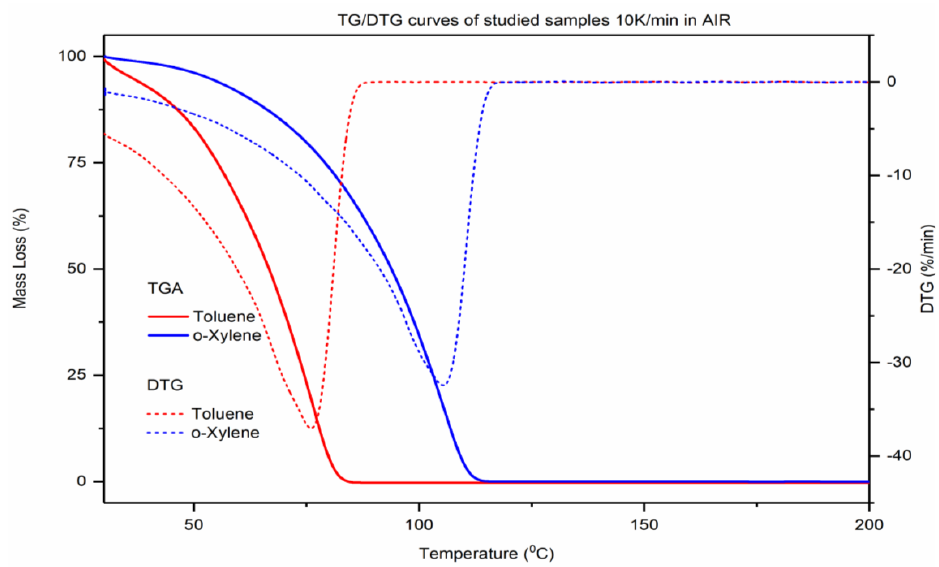
Figure 3. TG-DTG curves of the analyzed solvents (o-xylene (blue), toluene (red)). According to the thermal stability criteria, all of the selected solvents (toluene, xy- lene) are suitable for the next stage of steam filtration and enhanced oil recovery.